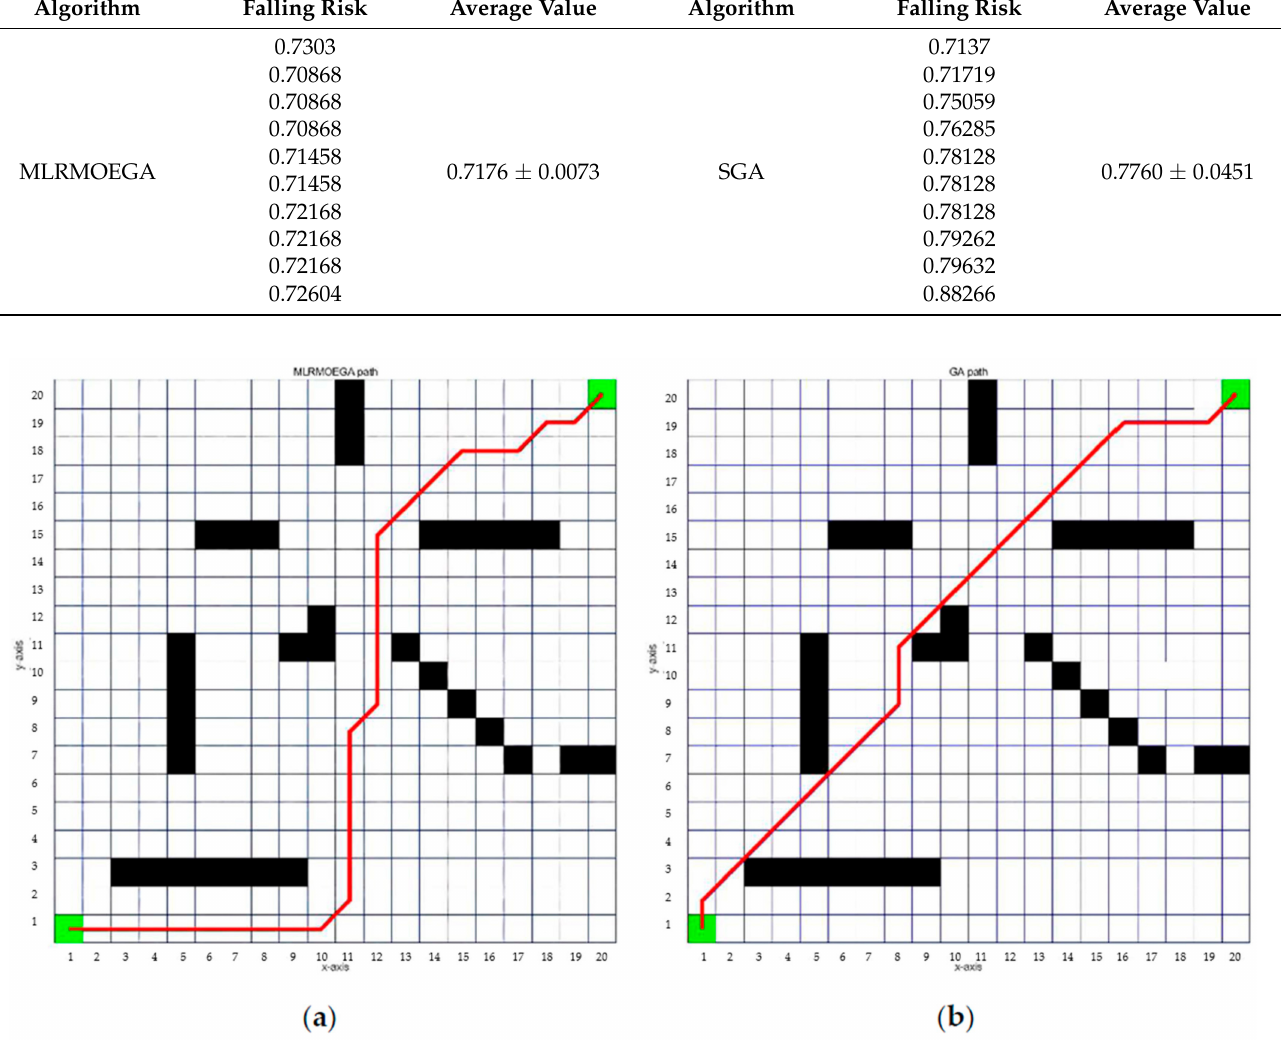
Figure 12. Results of artificial potential field test (with 20 × 20 grid map): ( a ) MLRMOEGA path (Falling risk: 0.7303); ( b ) SGA path (Falling risk: